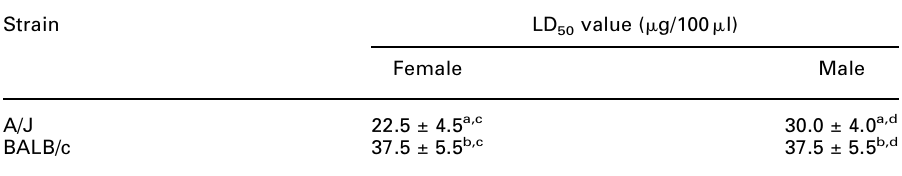
Groups of female and male from A/J and BALB/c strains, 16–20g of body weight, were injected i.p. with different amounts of TSV. Deaths occurring during 24h were recorded and the LD 50 value was calculated. a Not significant, b not significant, c p > 0.05, d not significant.